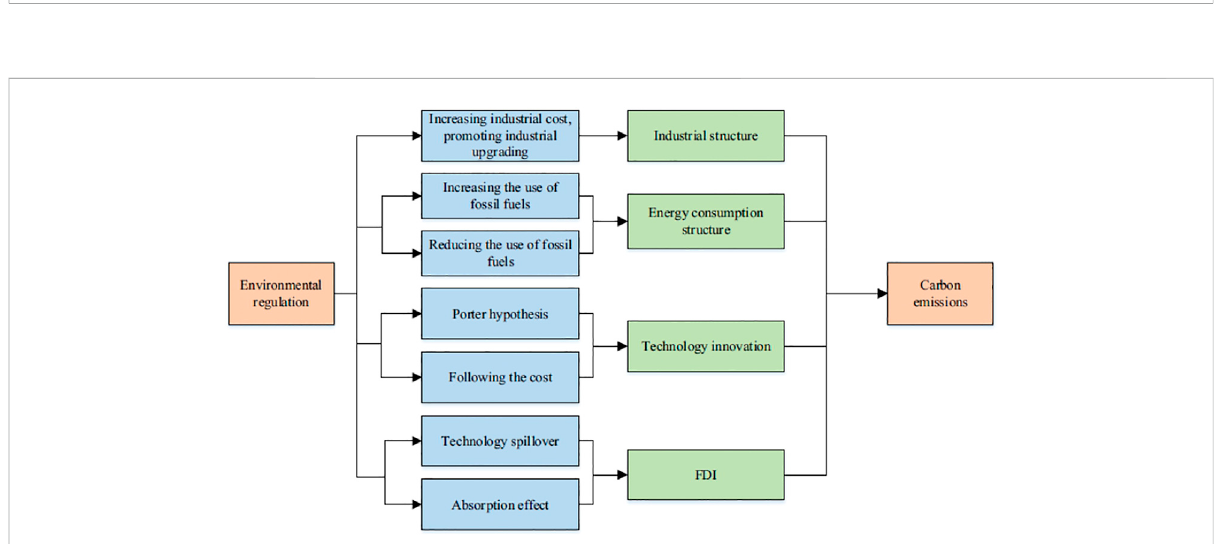
FIGURE 3 Indirect functional path of environmental regulation on carbon